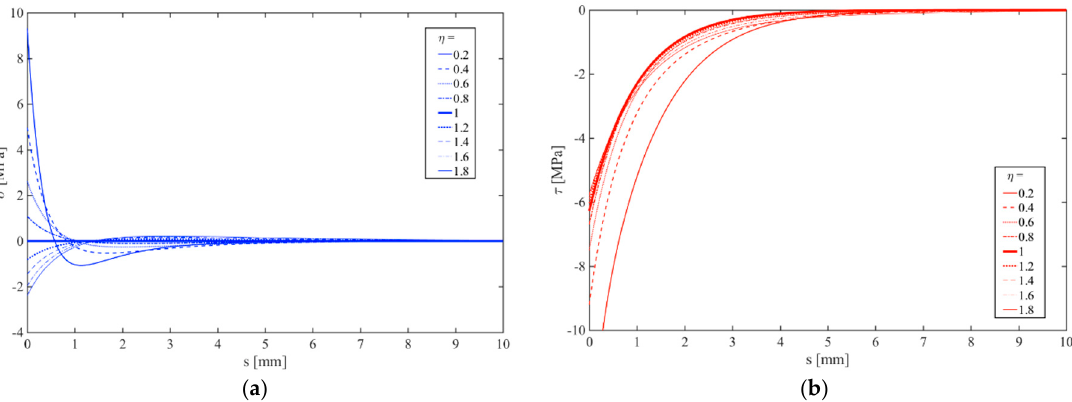
η Figure 12. Effect of the thickness ratio on the interface local response: ( a ) Normal stress; ( b ) Figure 12. Effect of the thickness ratio η on the interface local response: ( a ) Normal stress; ( b ) Tangential Tangential stress. (Isotropic specimen). stress. (Isotropic